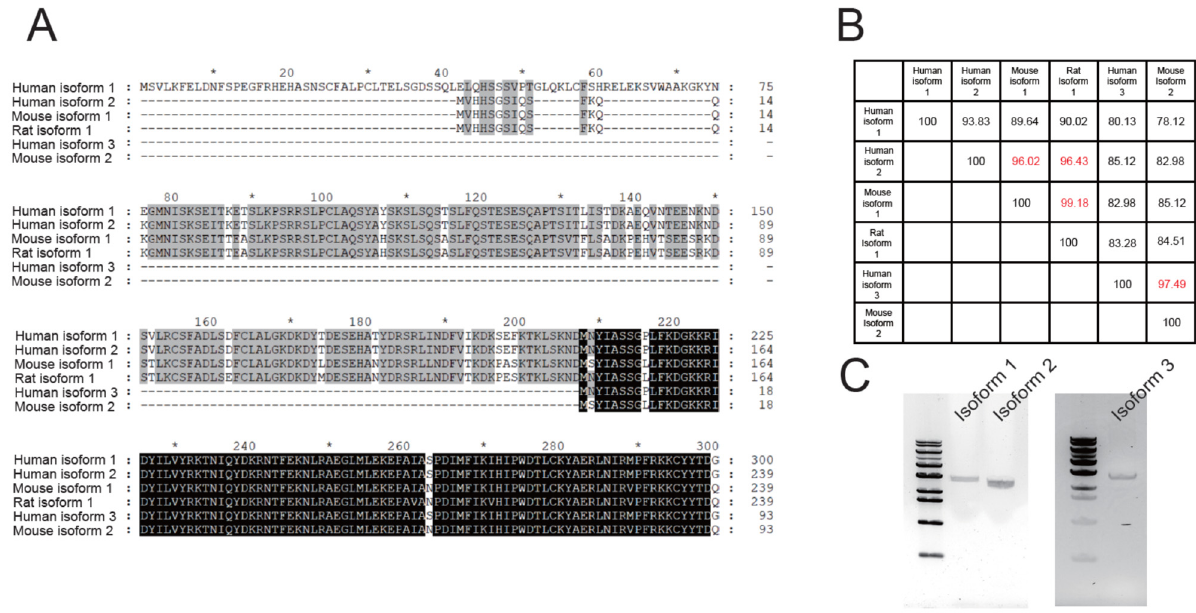
Figure 1. Three human TMEM16C isoforms and their similarity to other orthologues. ( A ) Sequence alignment of the N-terminal regions of human, mouse and rat TMEM16C isoforms. Alignment was conducted using Clustal Omega. ( B ) Sequence similarity between human TMEM16C isoforms and orthologues; similarity was calculated using the Ident and Sim program from the Sequence Manipulation Suite. ( C ) PCR results for human TMEM16C isoforms using cDNA from human brain. The first column in the gels is 1 kb DNA ladder to estimate the length of DNA.